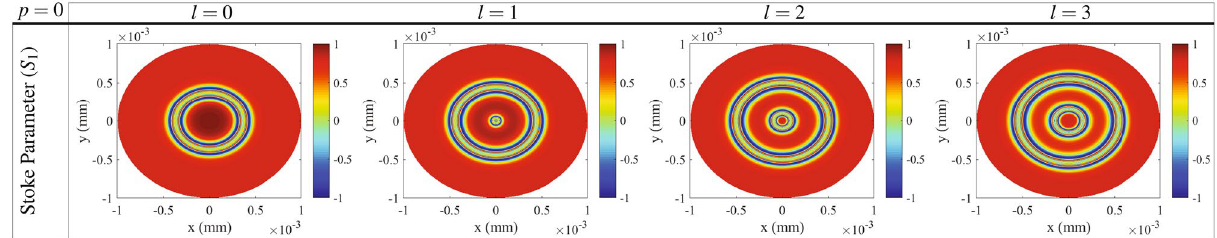
Figure 5. Profile of S 1 of Stokes parameters as a function of x and y for Gaussian and different modes of LG modes. The used parameters are those used in Fig.